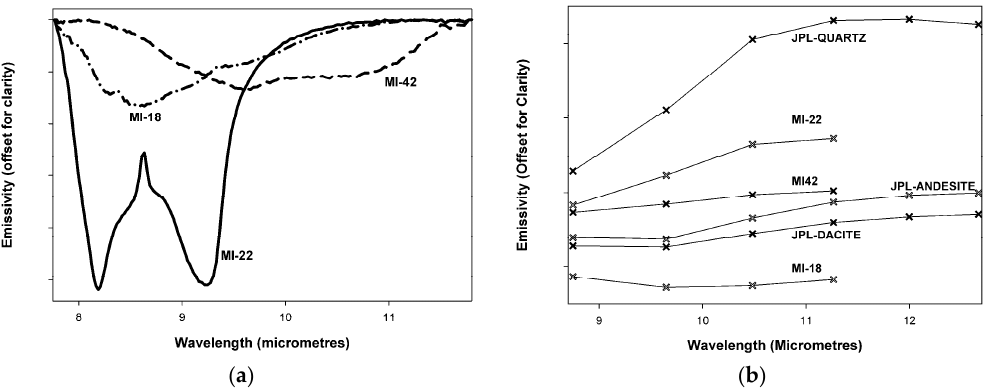
Figure 4. ( a ) Laboratory emission spectra of unaltered volcanic and silicified alteration zone. Numbers in labels indicate field site (Table 1). ( b ) Emission spectra from Milos (shown in Figure 4a) and related emission spectra from the JPL library [57] resampled to the DAIS TIR bandwidths.